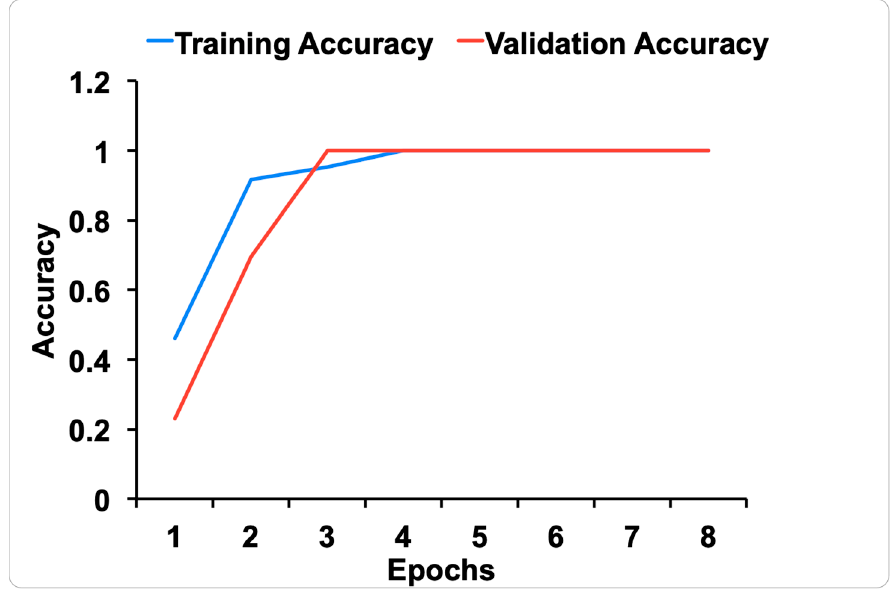
Figure 6. CNN-based model accuracy for classifying manipulation images.